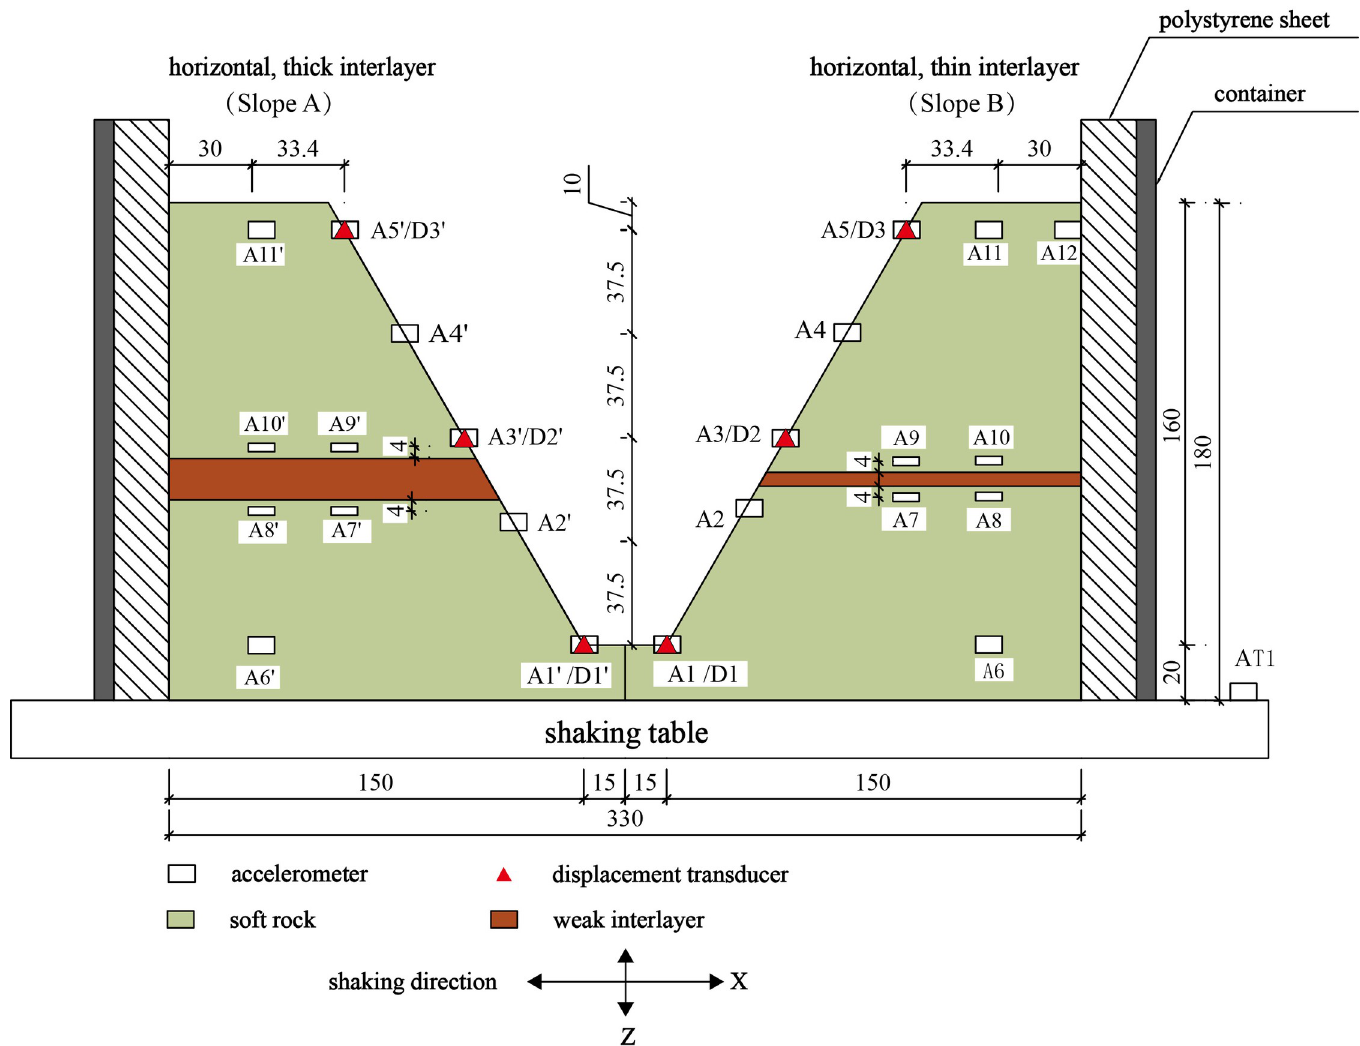
Fig 2. Schematics of model slopes in shaking table test with sensor arrangement (Unit: Cm).